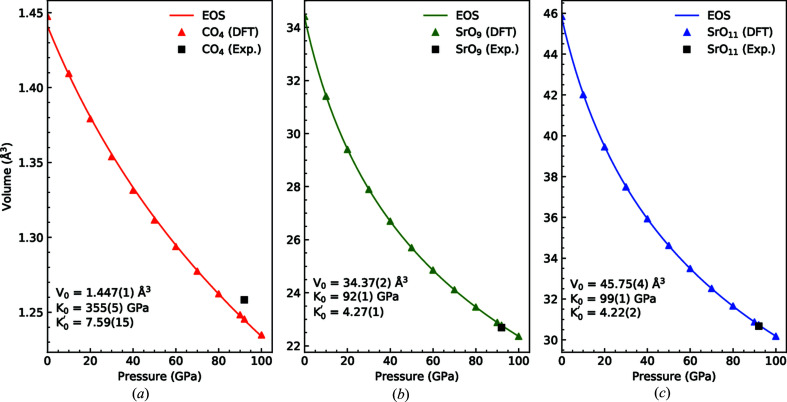
Pressure–volume evolution of the three building blocks of Sr2CO4: CO4 (a), SrO9 (b) and SrO11 (c). As expected from its short and rigid C—O single bonds the CO4 tetrahedron is found to be very incompressible.